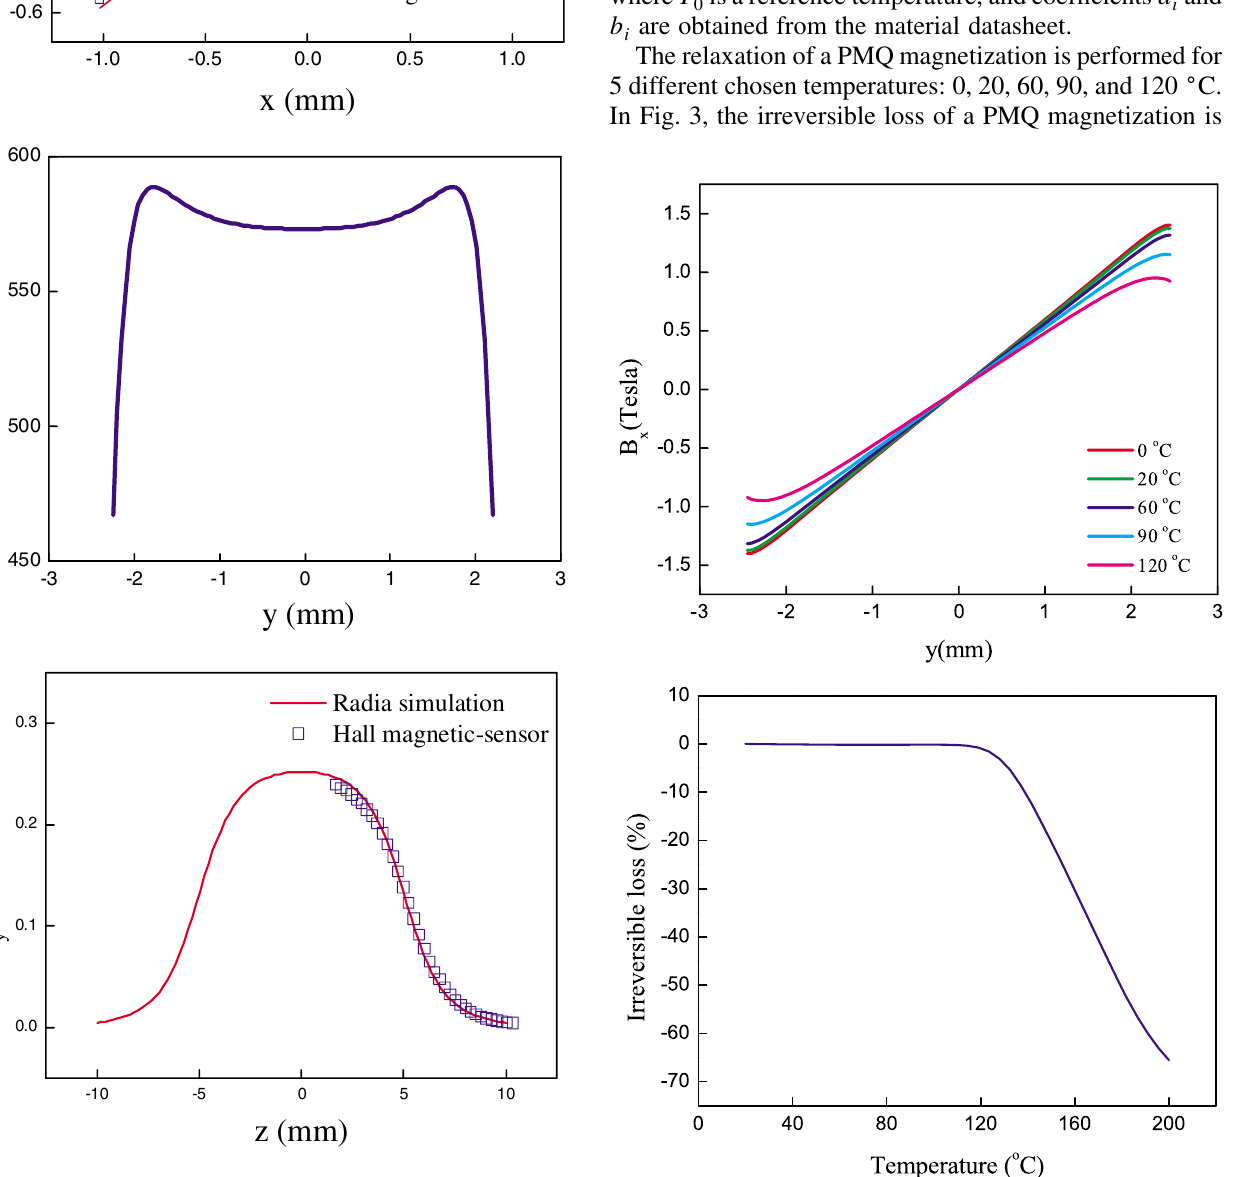
FIG. 2. (Color) 3D code RADIA PMQ field: a comparison of PMQ field profile measurements using a Hall probe to RADIA simulation results (top), the field gradient (middle), and the effective magnetic length taken at r (cid:2) 2 : 0 mm